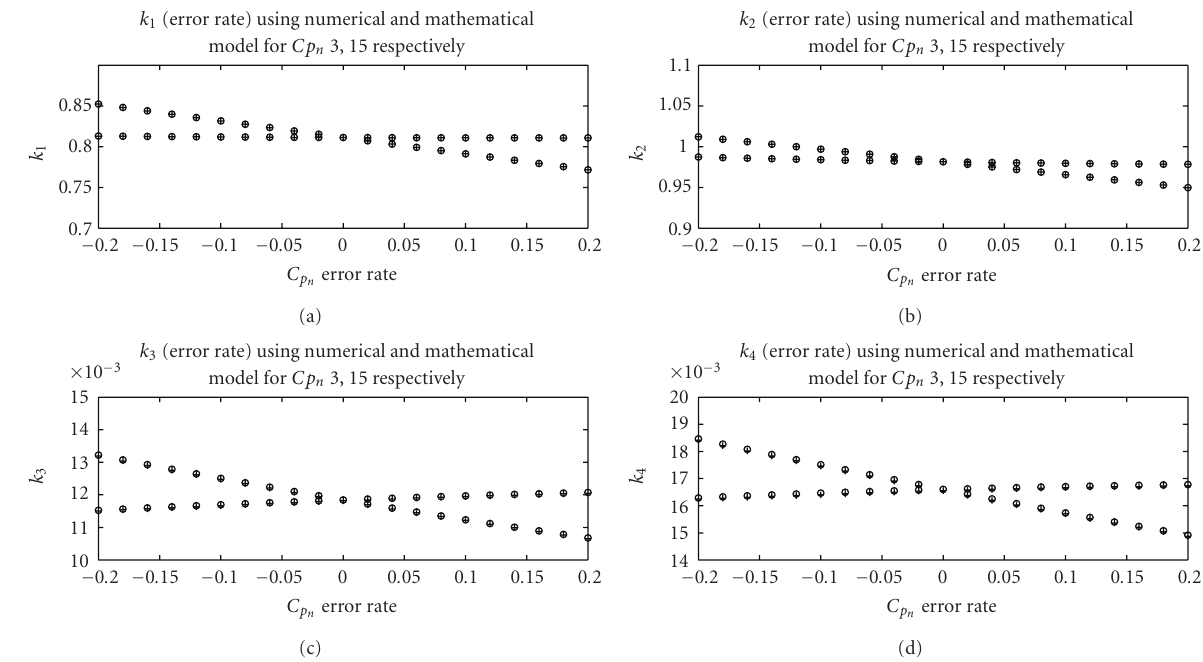
Figure 4: Comparison between the estimated k 1 , k 2 , k 3 , and k 4 of liver using the derived expressions and numerical method for a range of erroneous blood functions. A single sample out of 19 samples of C p